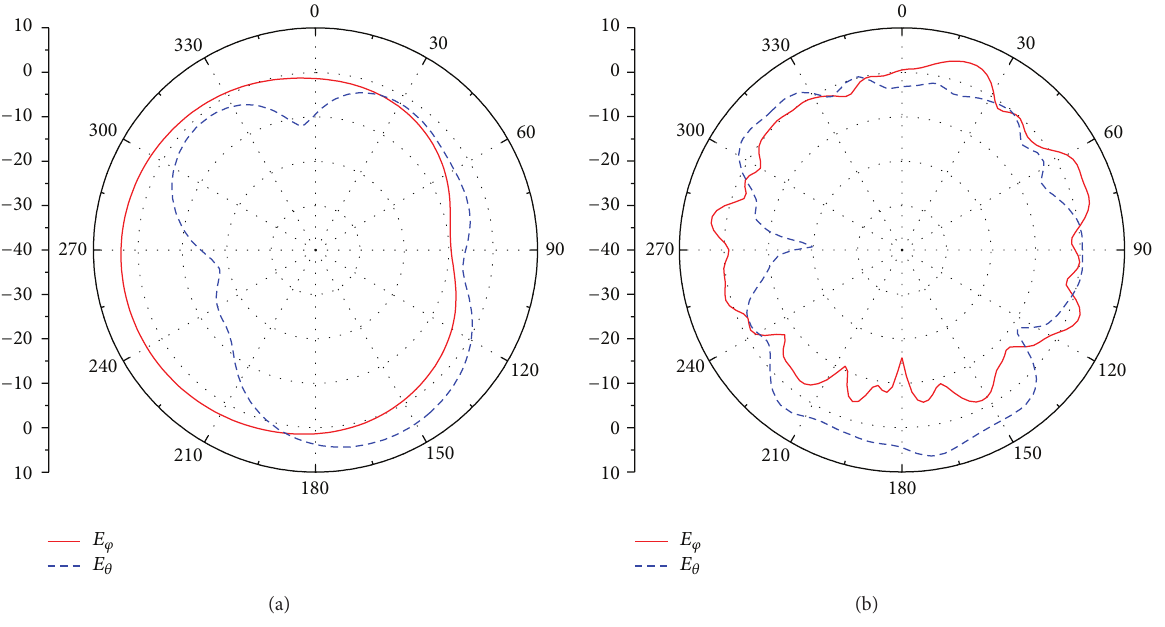
Figure 18: Simulated radiation patterns of the final MIMO antenna in 𝑥𝑧 -plane at (a) 4 GHz and (b) 9 GHz.